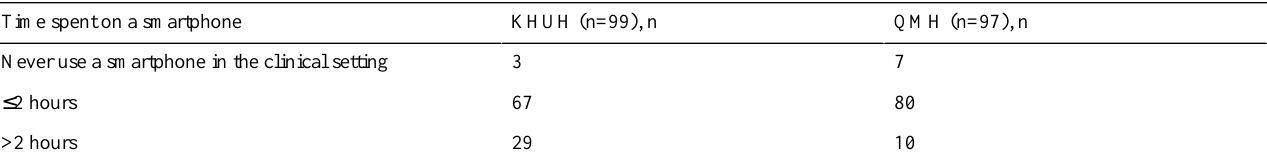
Table 4. Time spent on a smartphone by doctors in King Hamad University Hospital (KHUH) and Queen Mary Hospital